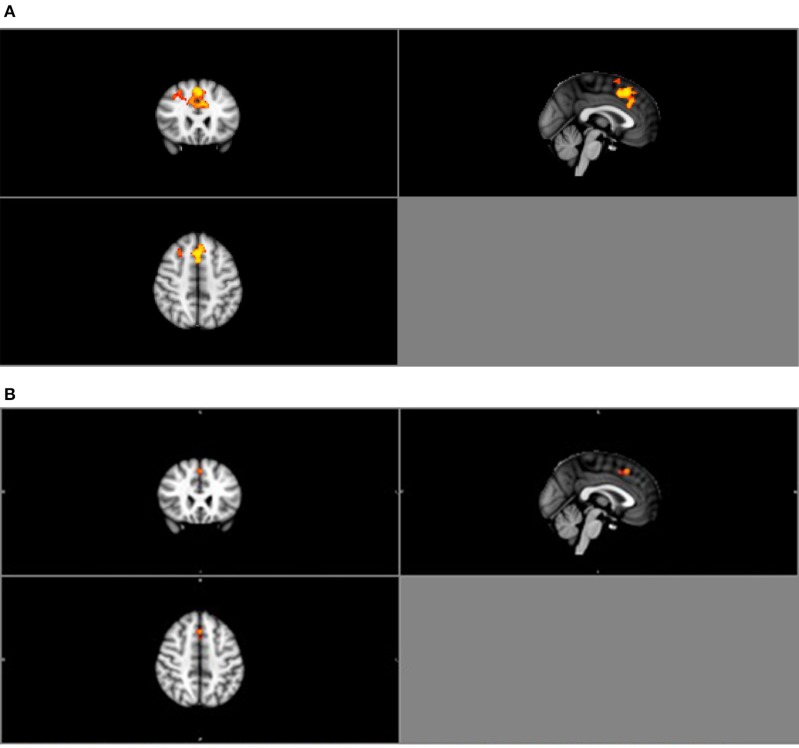
(A) Group contrast during finger tapping. Highlighted areas show regions where Normal > Obese in DMN functional connectivity (P < 0.05) during finger tapping. (B) Bonferroni-corrected group contrast during finger tapping. Highlighted areas show regions where Normal > Obese in DMN functional connectivity (p < 0.006) during finger tapping.